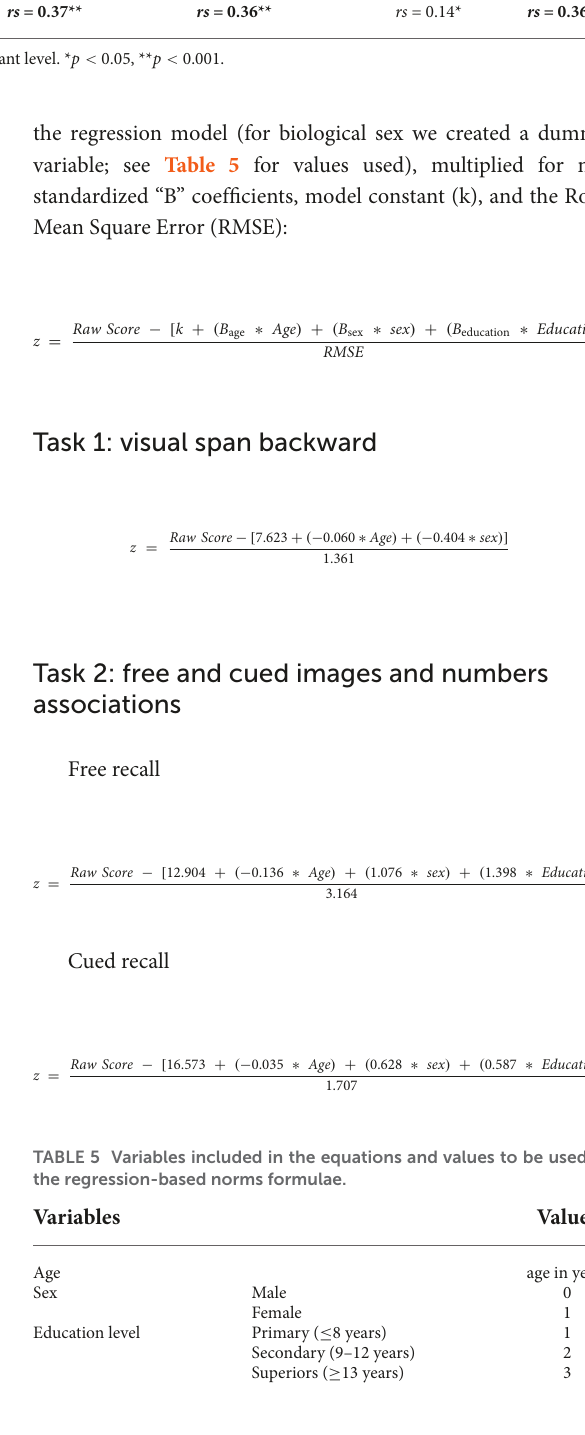
TABLE 4 Correlations between results of the “Guttmann Cognitest” (cid:114) digital solution and those obtained by classical paper and pencil neuropsychological testing.